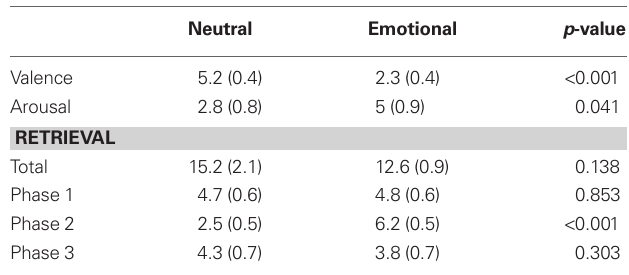
Table 1 | Mean (SeM) scores of behavioral data for each